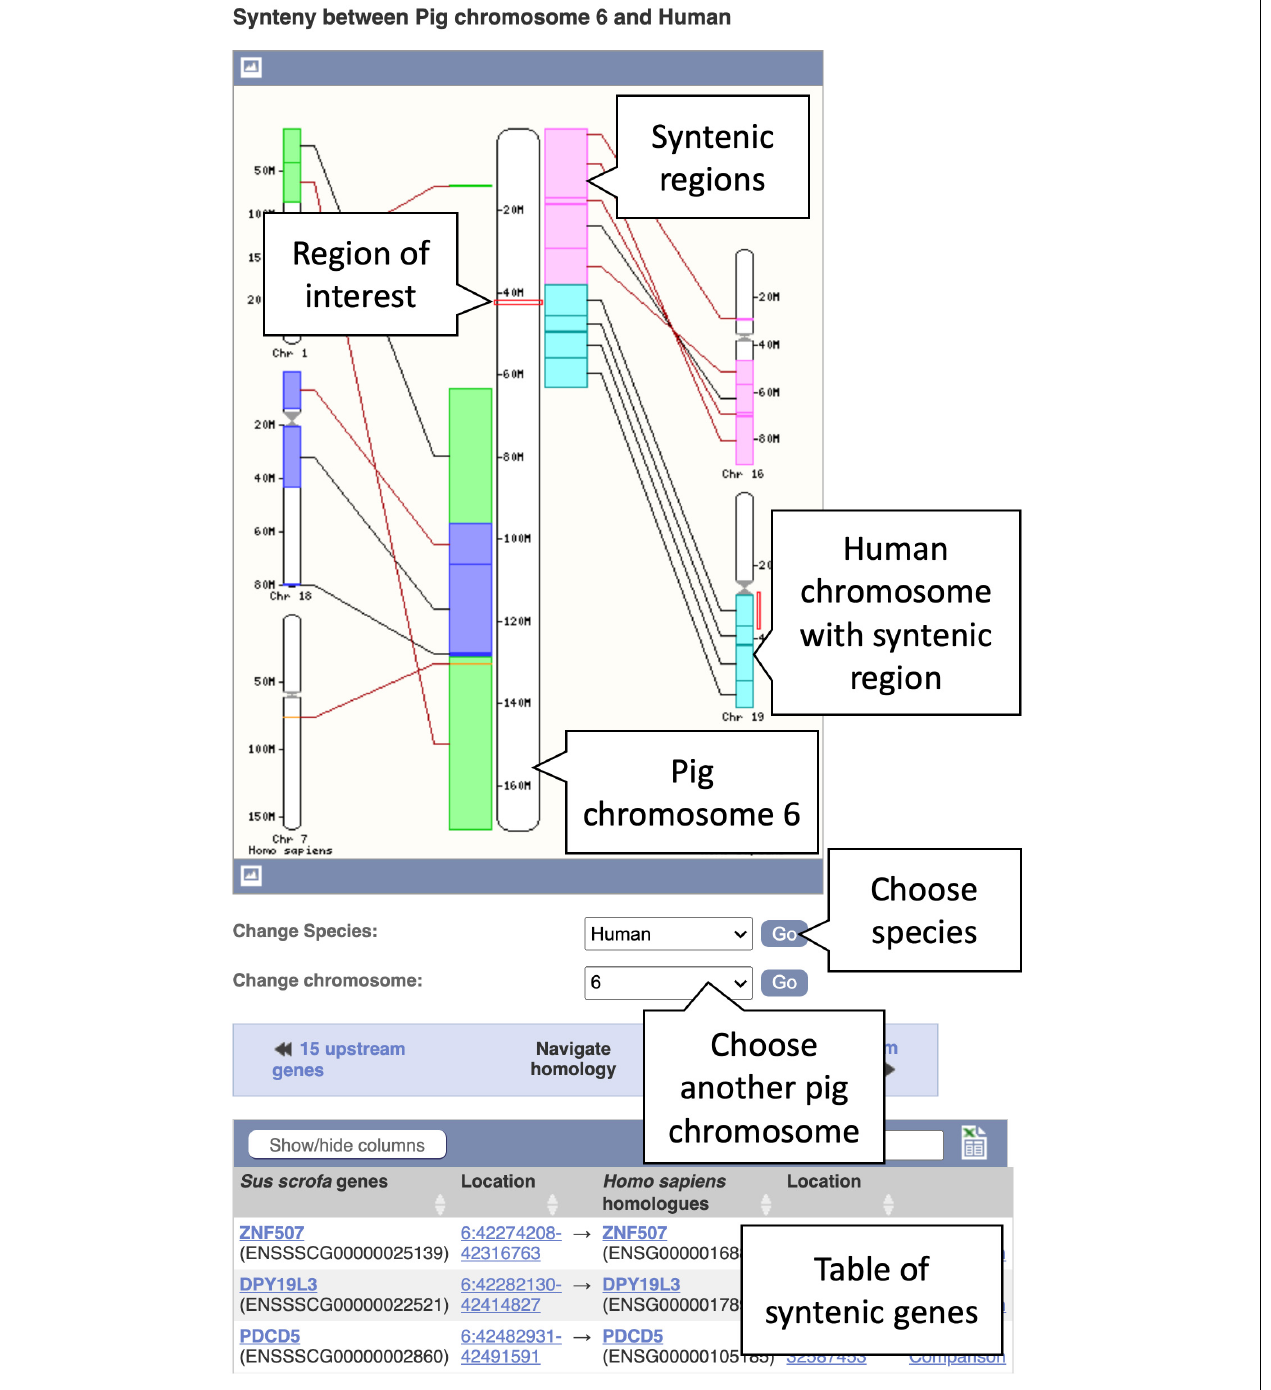
FIGURE 5 | A synteny map from pig chromosome 6 to human. Regions on pig chromosome 6 (located in the centre) are syntenic to multiple regions on human chromosomes 1, 7, 16, 18, and 19 (shown on the left- and right-hand sides). Syntenic blocks are coloured according to the chromosome numbers for human. The blocks are connected by lines, whereby black lines connect blocks with the same orientation and brown lines indicate blocks with the opposite orientation.